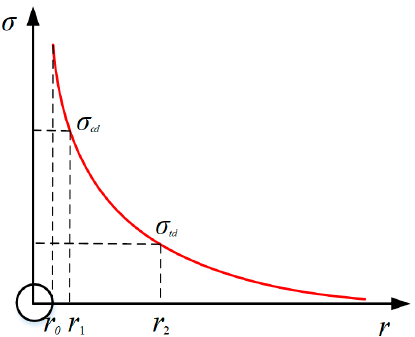
Figure 13. Stress wave intensity decay pattern. σ is Stress wave strength; r is the distance to the center of the blast hole; σ cd is the dynamic compressive strength of the test block; σ td is the dynamic tensile strength of the test block; r 0 is the radius of the blast hole.